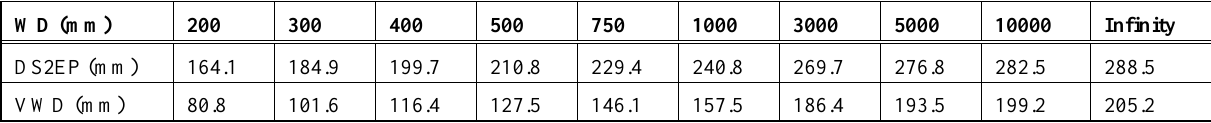
Table 2. Real object distance versus its virtual image underwater for the NiMAR NI320 dome port.